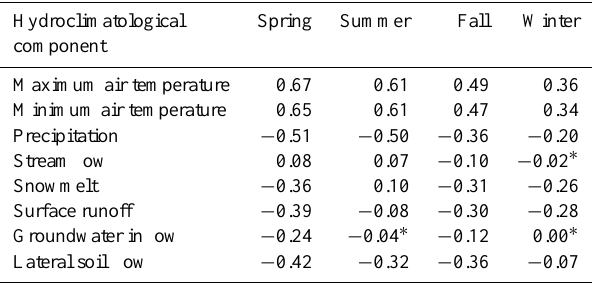
Table 5. Pearson correlations between stream temperature and in- dividual hydroclimatological changes for the entire Columbia River basin during the